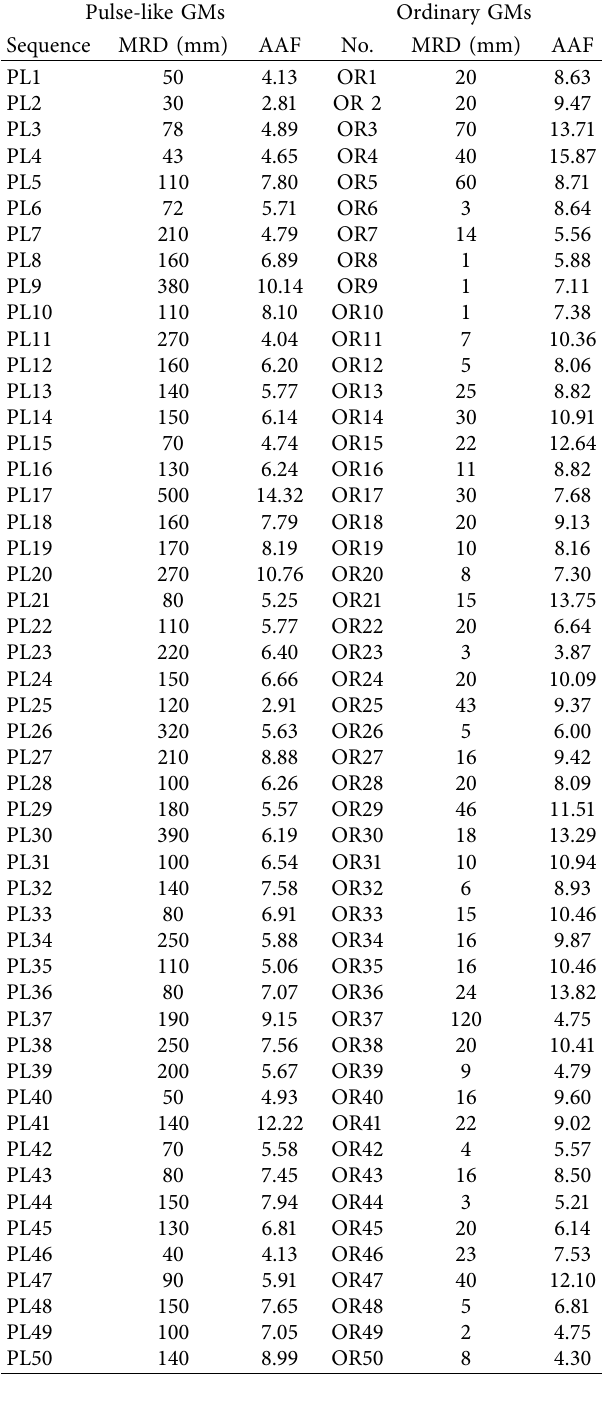
Table 6: Structural responses to pulse-like GMs and ordinary GMs. Pulse-like GMs Ordinary